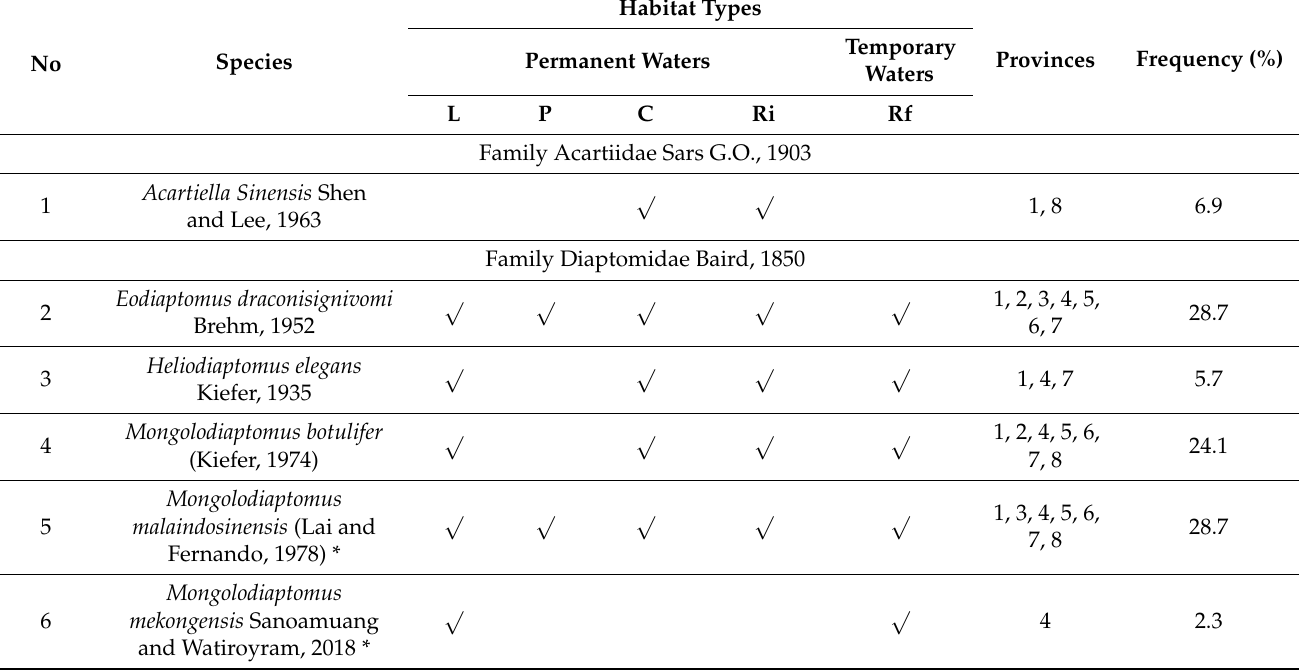
Table 3. List of calanoid copepods recorded, with their habitat types, provinces where they occur, and frequency percentages. Frequency percentages were calculated from the cumulative number of the 87 sampling sites in Southern Vietnam. L = lake, P = pond, C = roadside canal, Ri = river, and Rf = rice field. Provinces are represented by numbers 1–8: 1 = Ho Chi Minh City, 2 = B à R ị a–V ũ